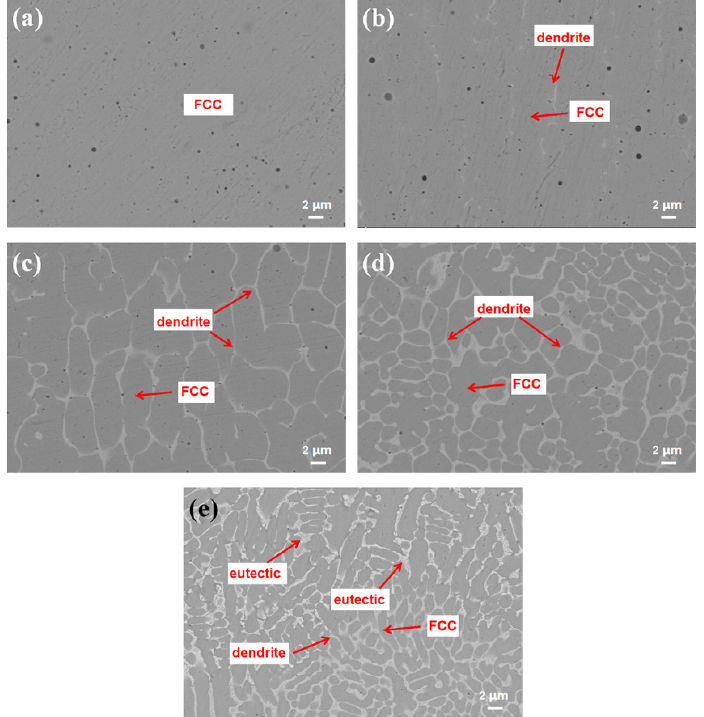
Figure 6. Local magnification FESEM images of coatings: ( a ) CoCrFeNi HEAC; ( b ) CoCrFeNi HEACC (10 wt.% WC); ( c ) CoCrFeNi HEACC (20 wt.% WC); ( d ) CoCrFeNi HEACC (30 wt.% WC); ( e ) CoCrFeNi HEACC (40 wt.% WC).